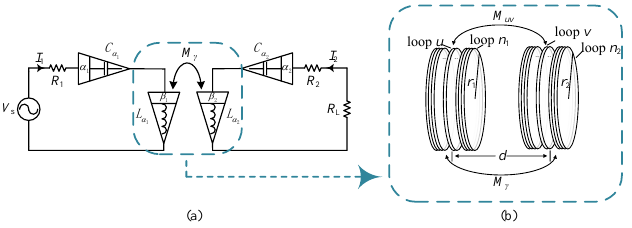
Figure 4. (a) Schematic of FO-WPT and (b) its coil-to-coil